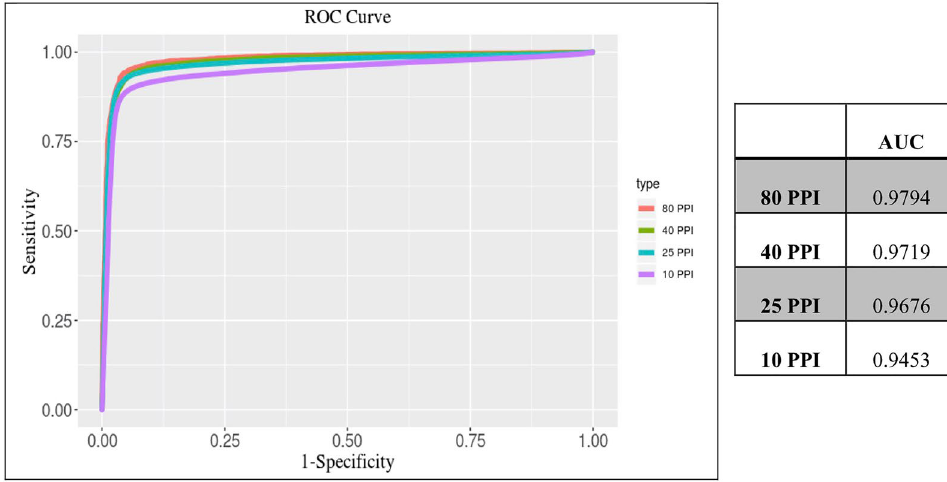
Figure 1. Receiver operator characteristic (ROC) curves of photoplethysmogram (PPG) models including the six independent PPG features extracted from the 10, 25, 40, and 80-beats of the pulse-to-pulse interval to detect AF.